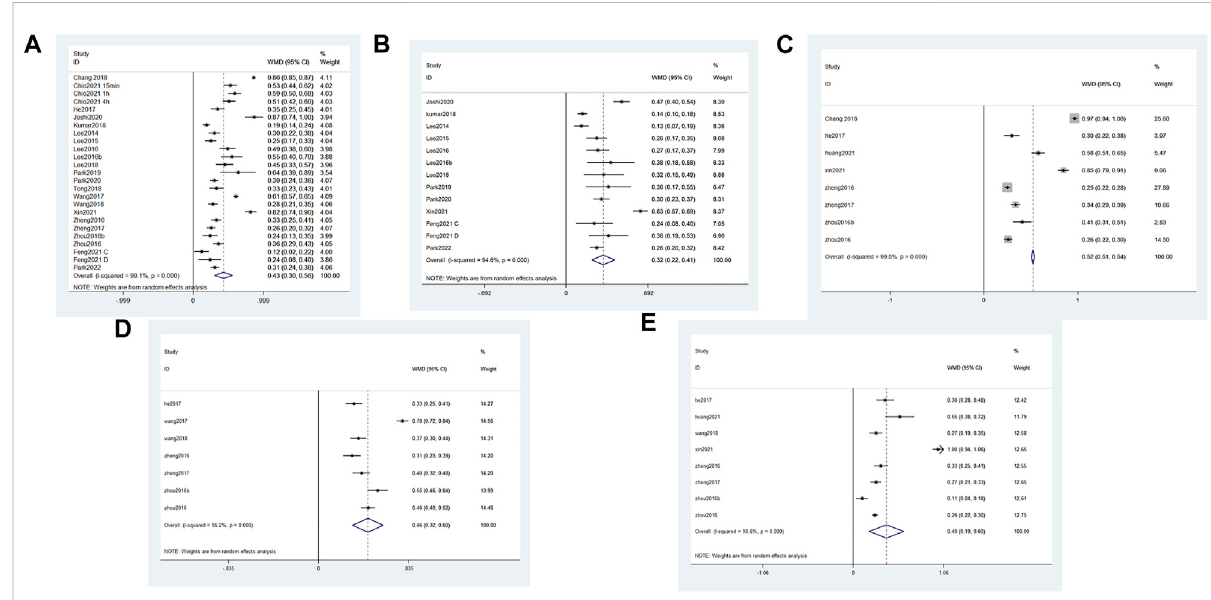
FIGURE 4 Forest plot of increased TJ and AJ protein expression in different studies. Black dots indicate weighted effect sizes of treatment regimens, and errorbarsindicate95%con fi denceintervalsforeachoutcome.Thediamondboxistheoveralleffectsizeanditscon fi denceinterval. (A) Forestplotof Occludin expression (B) Forest plot of ZO-1 expression (C) Forest plot of Claudin5 expression (D) Forest plot of P120 expression (E) Forest plot of β - catenin expression.